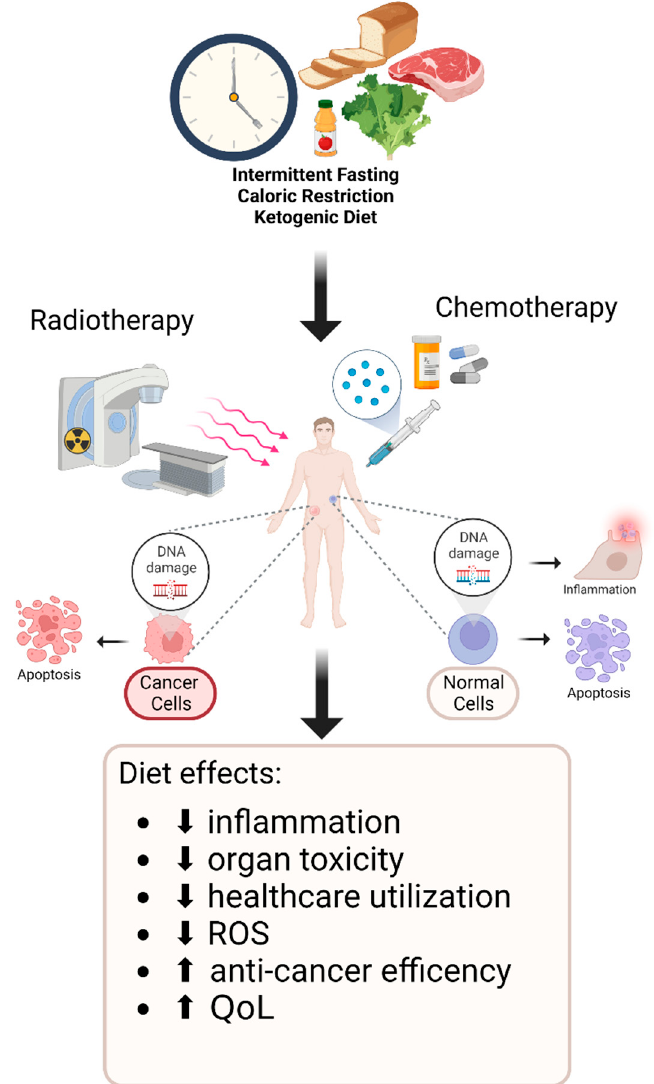
Figure 1. Potential positive effects of dietary interventions on patients receiving cancer treatment. Quality of life (QoL) is a parameter that is used to determine the well-being of an individual both physically and psychologically. Reactive oxygen species (ROS) are unstable molecules which induce DNA damage, thereby leading to cell death.